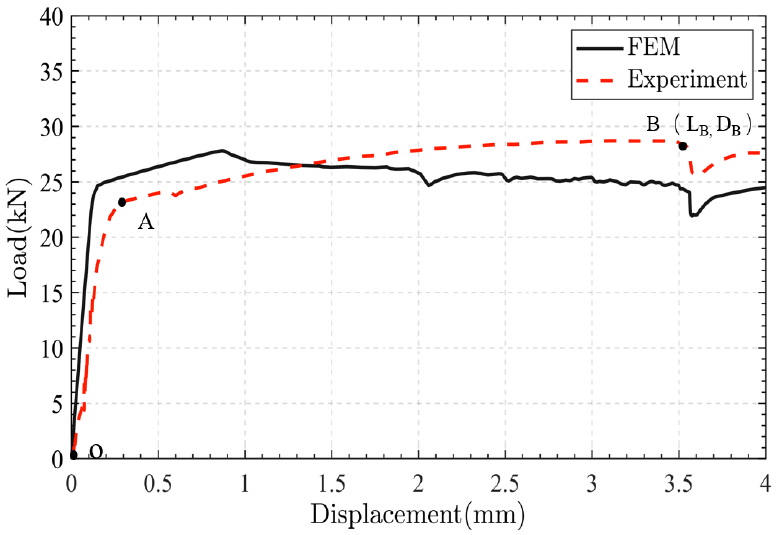
Figure 10. Load – displacement curve of the anchorage model. Figure 10. Load–displacement curve of the anchorage